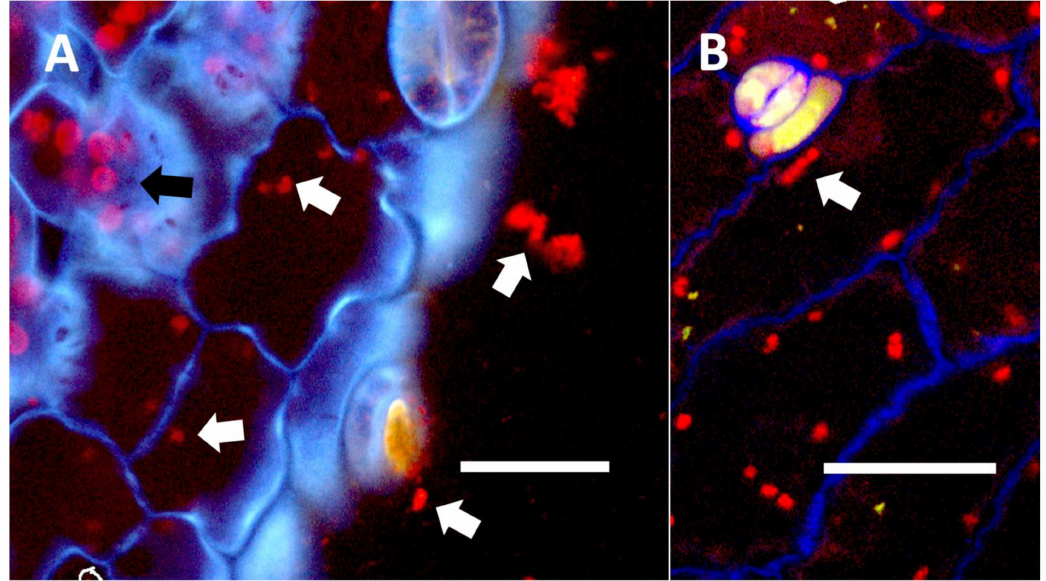
Figure 16. Trifolium pratense seedling leaves showing bacteria within epidermal cells. ( A ) Trifolium pratense leaf from inoculation experiment showing red colored mCherry-tagged Klebsiella oxytoca cells (white arrows) within epidermal cells and outside the leaf (Bar = 10 µ m). Chloroplasts (black arrow) are evident in the mesophyll cells beneath the epidermis. ( B ) Trifolium pratense leaf from inoculation experiment showing red colored mCherry-tagged Klebsiella oxytoca cells within epidermal cells (Bar = 10 µ m). The white arrow shows a chain of bacterial